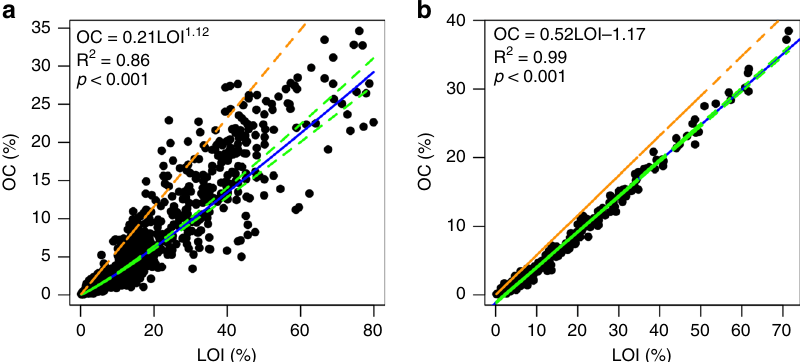
Fig. 1 Sediment organic carbon and loss on ignition relationship. a The relationship for mangroves. b The relationship for saltmarshes. The green dotted lines are the 95% con fi dence intervals. The brown dotted line represents the relationship of the van Bemmelen factor (OC/LOI